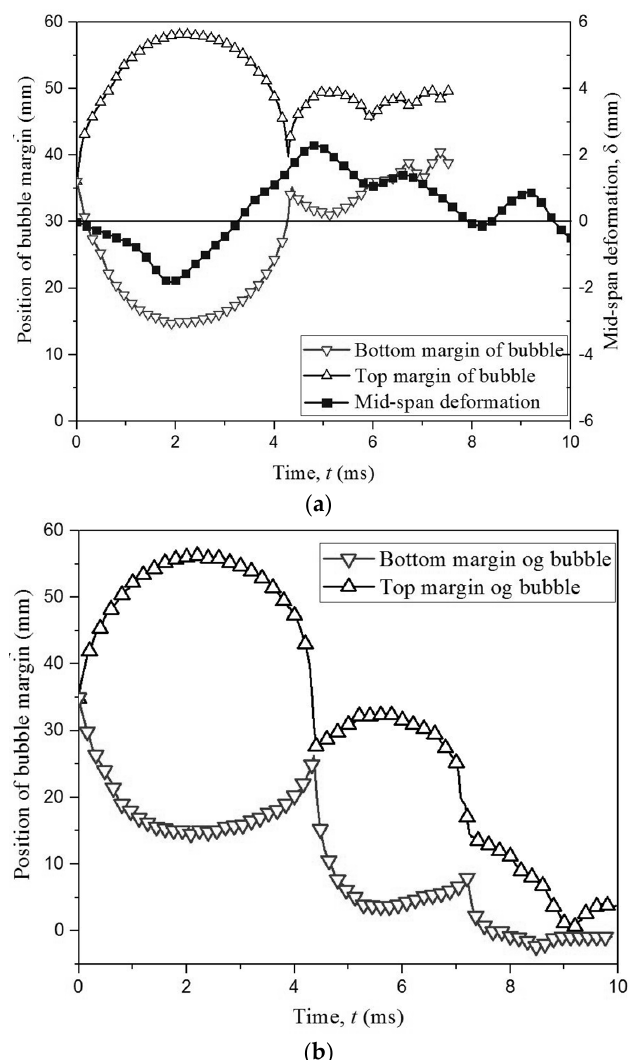
Figure 13. ( a ) The comparison of the temporal evolution of two bubble margins and mid-span displacement of elastic boundaries for γ = 1.68 and R m = 21.0 mm [39]; ( b ) the temporal evolution of two bubble margins near the rigid boundary for γ = 1.68 and R m = 21.0 mm.